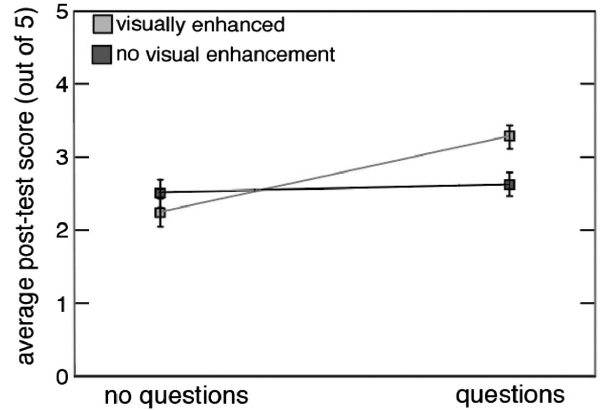
FIG. 10. Model 2 interaction between enhanced visuals and embedded questions in predicting postvideo test